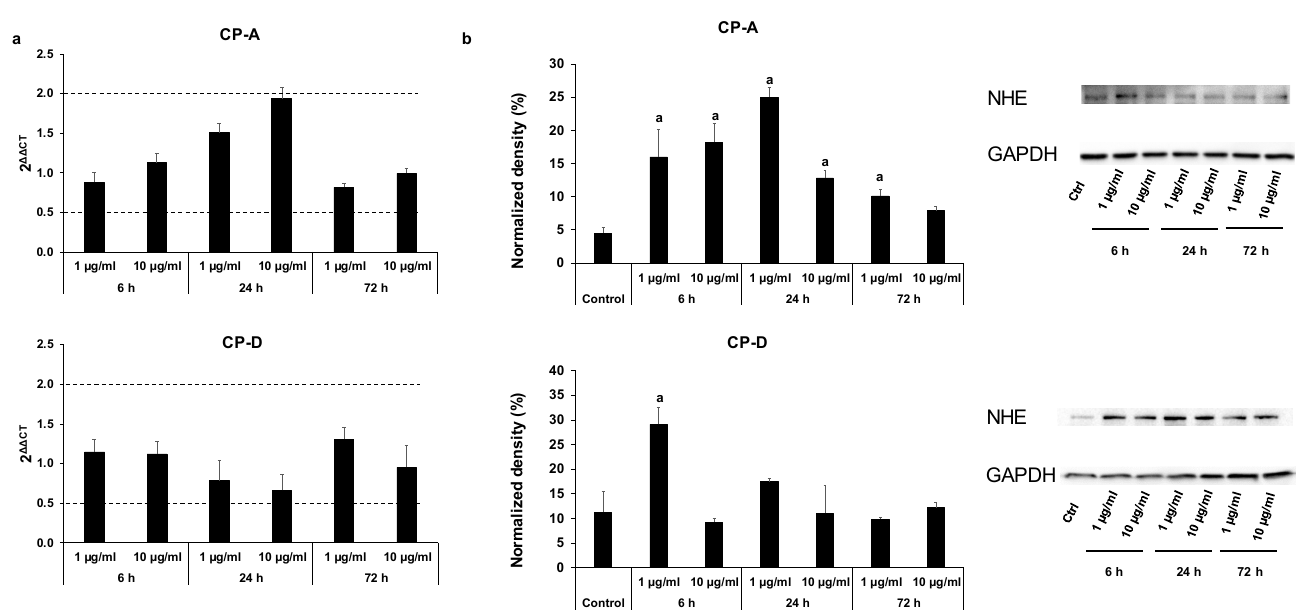
Figure 4. Effects of cigarette smoke extract (CSE) treatment on the mRNA and protein expression of Na + /H + exchanger-1 (NHE-1) in esophageal cell lines. Metaplastic (CP-A) and dysplastic (CP-D) esophageal cell lines were treated with dif-ferent concentrations of CSE (1 and 10 µ g/mL) for 6, 24 and 72 h, and the relative gene ( a ) and protein ( b ) expressions of NHE-1 were investigated by real-time PCR and Western blot, respectively. GAPDH was used as a protein-loading control. Data represent mean ± SEM of three independent experiments; a = p ≤ 0.05 vs. control.